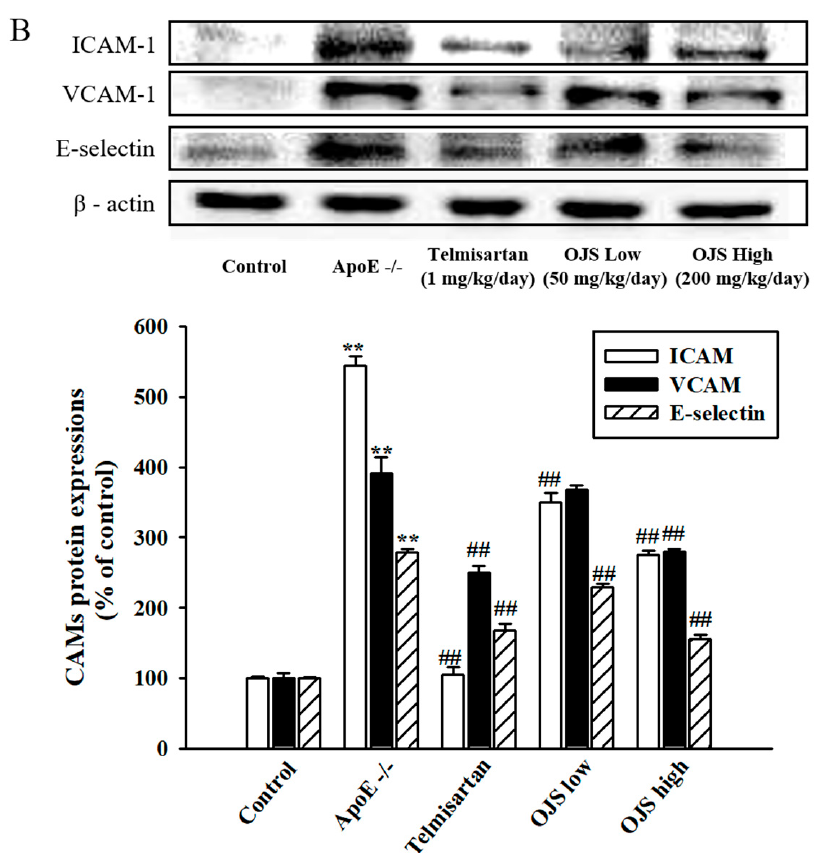
Figure 4. Effects of OJS on intracellular adhesion molecule-1 (ICAM-1), vascular cell adhesion molecule-1 (VCAM-1), and endothelial cell selectin (E-selectin) expression in the aortas of ApoE − / − mice ( A ). ICAM-1, VCAM-1, and E-selectin immunofluorescence in the aortas of ApoE − / − mice. Immunofluorescence staining of adhesion molecules in the aortas from the control, ApoE − / − , ApoE − / − mice treated with telmisartan groups, and ApoE − / − mice treated with OJS at low or high concentrations. Protein levels of the adhesion molecules determined by Western blot analysis ( B ). Data are presented as means ± S.E. ** p < 0.01 vs. control group; ## p < 0.01 vs. ApoE − / − group.